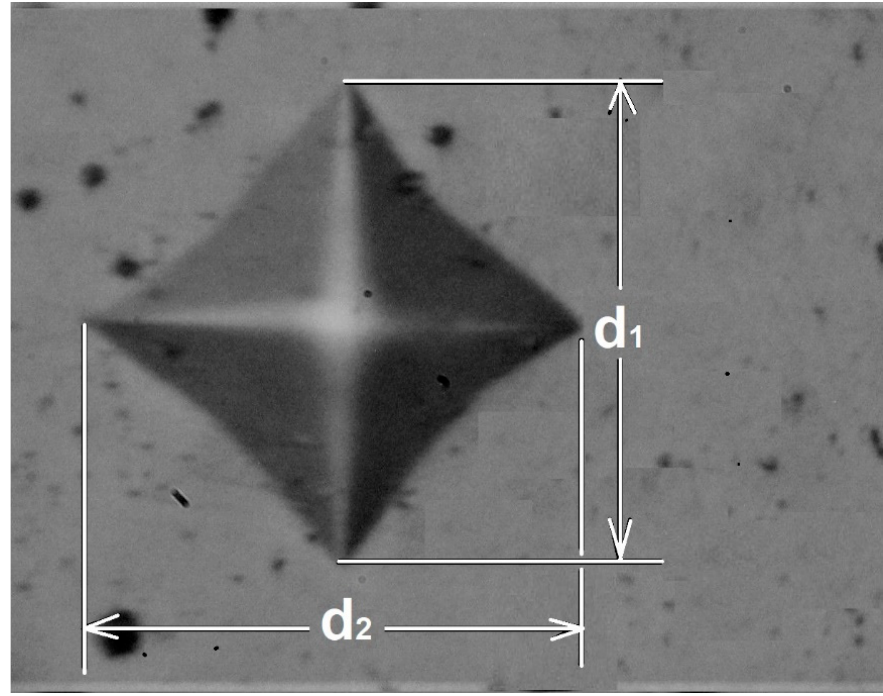
Figure 2. Scheme of the measurement of the diagonals of the permanent print.